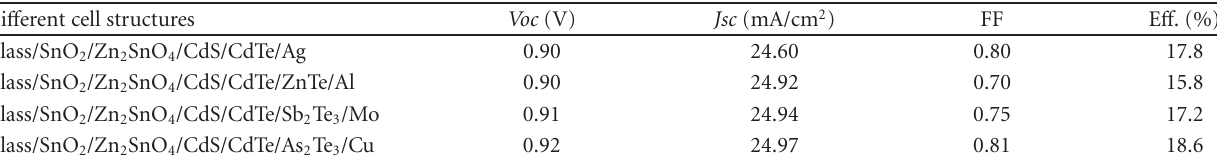
Table 2: Output parameters of di ff erent cells with BSF.